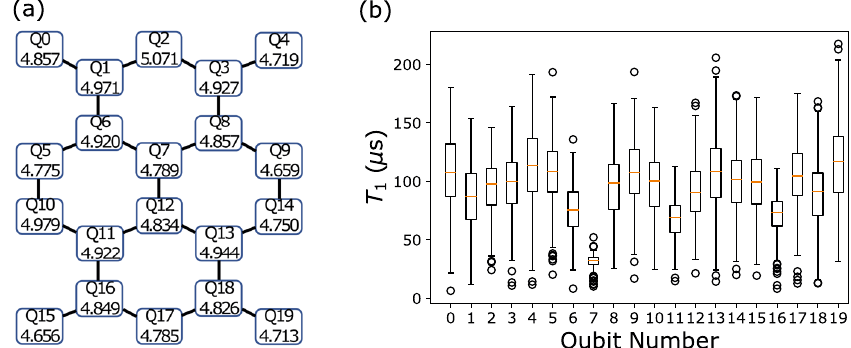
Fig. 1 Device map and T1s. a Map of a 20 qubit device including the qubit number, two-qubit connectivity, and the qubit frequency in (GHz). b Box and whisker plot of T 1 ’ s measured